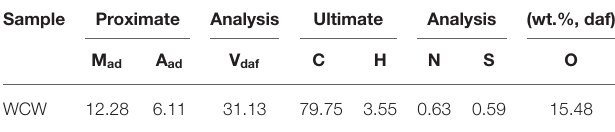
TABLE 1 | Proximate analysis and ultimate analysis of WCW coal. Sample Proximate Analysis Ultimate